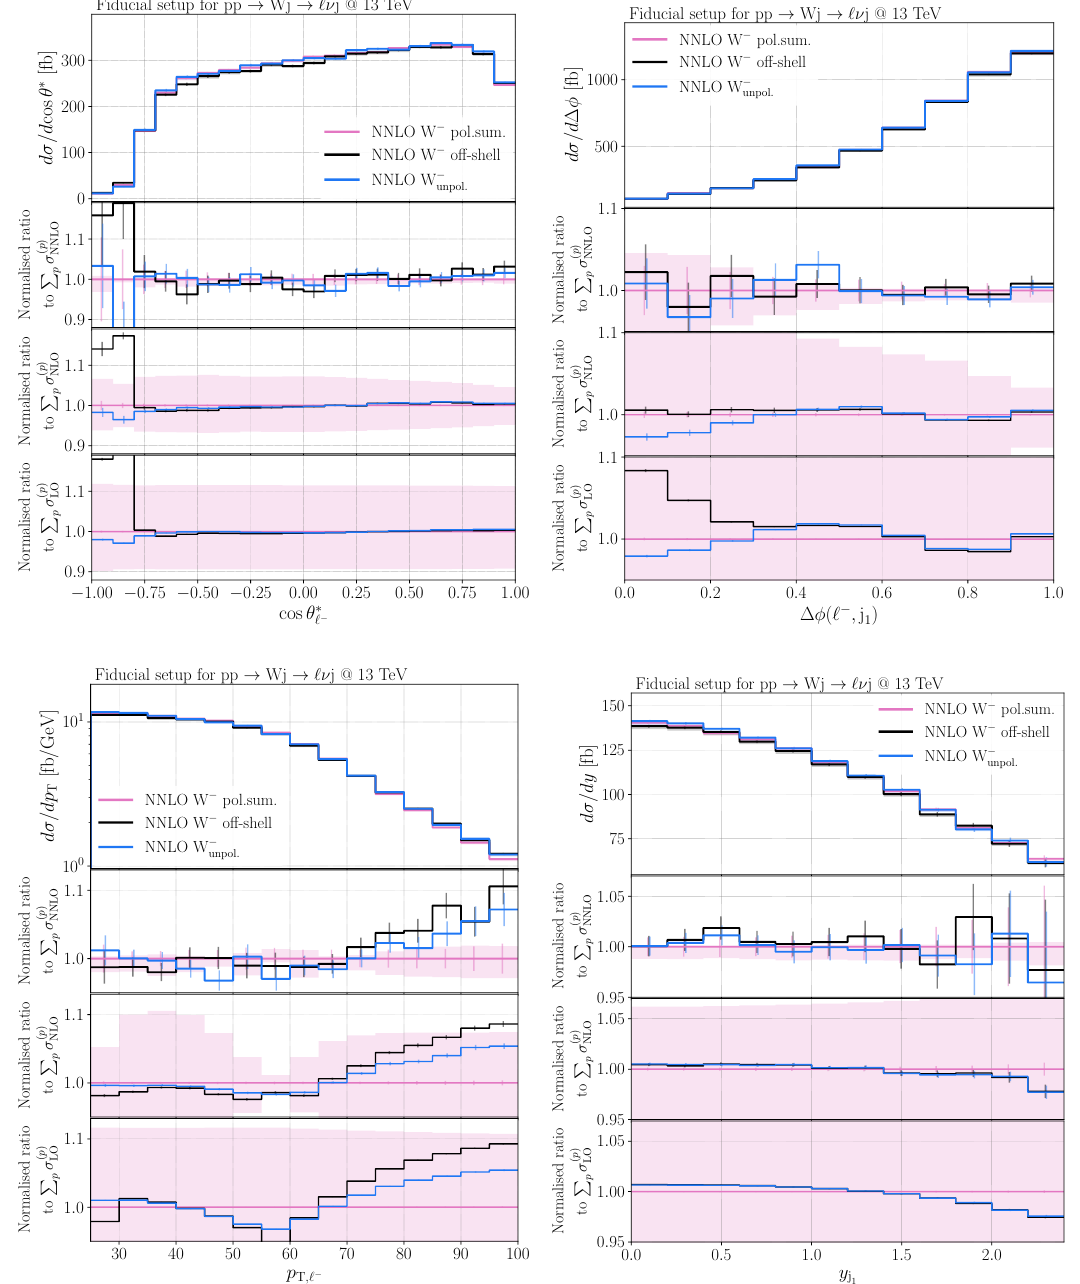
(top left), Figure 12 . Differential distributions for pp → ‘ − ¯ ν ‘ j in the fiducial setup: cos θ ∗ ‘ − ∆ φ ( ‘ − , j ) (top right), p (bottom left), and p (bottom right). The upper pane shows absolute ‘ − W − 1 distributions at NNLO QCD in the following setups: unpolarised NWA, the sum of polarised NWA, and off-shell. The other three panes feature the same distributions normalised to the sum of polarised setups at LO, NLO and NNLO. The pink band represents the 7-point scale variation for the ratio denominator, while the bars indicate the Monte Carlo